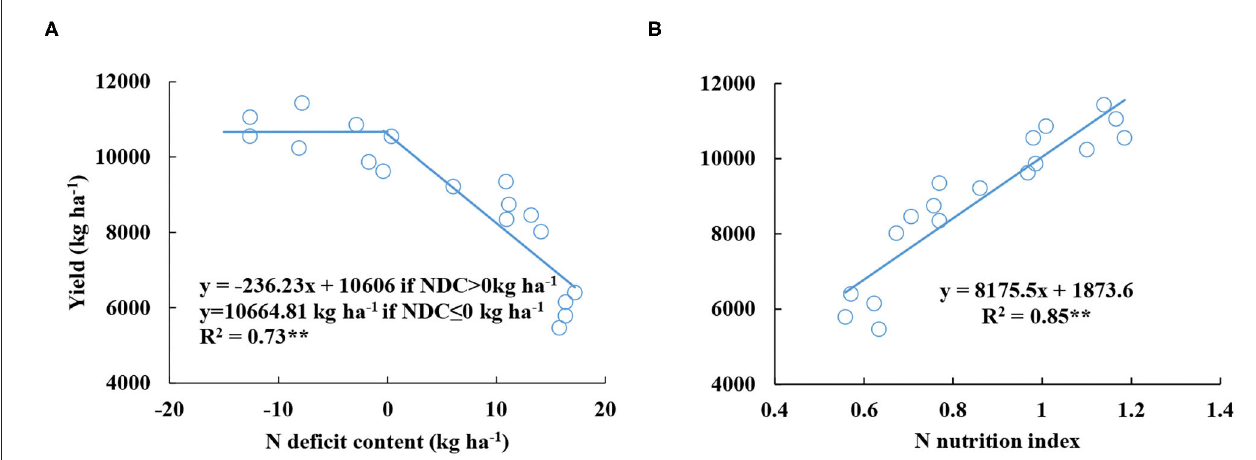
FIGURE 5 | Relationships between nitrogen nutrition index and nitrogen deficit content from V6 to V12 stages of corn during the 2015–2016 growing seasons (experiments 1–4).